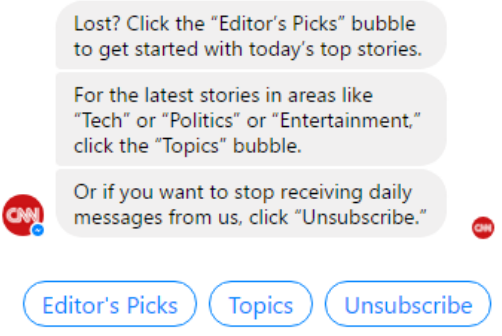
Fig. 2. Example of metalinguistic sign on the CNN’s chatbot.